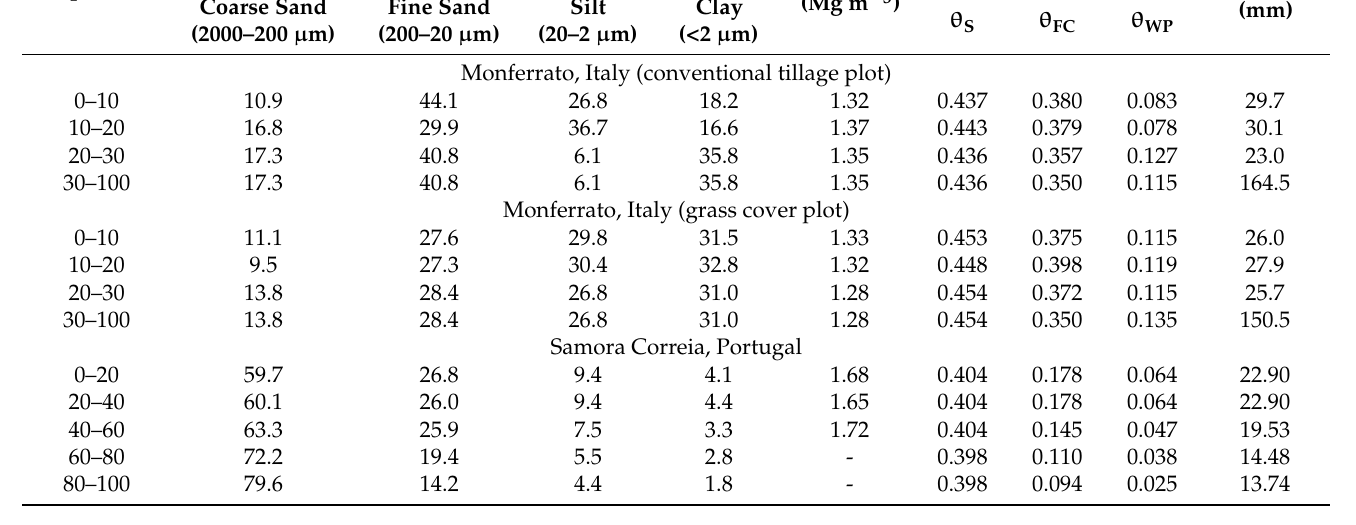
Figure 1. Weather data for Monferrato plots during the study period (P, precipitation, ET o , reference evapotranspiration; T max and T min , maximum and minimum air temperatures, RH avg , mean relative humidity; R s , solar radiation, u 2 , wind speed at 2 m height).